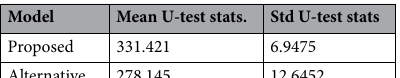
Table 8. Significance comparisons of the proposed and alternative